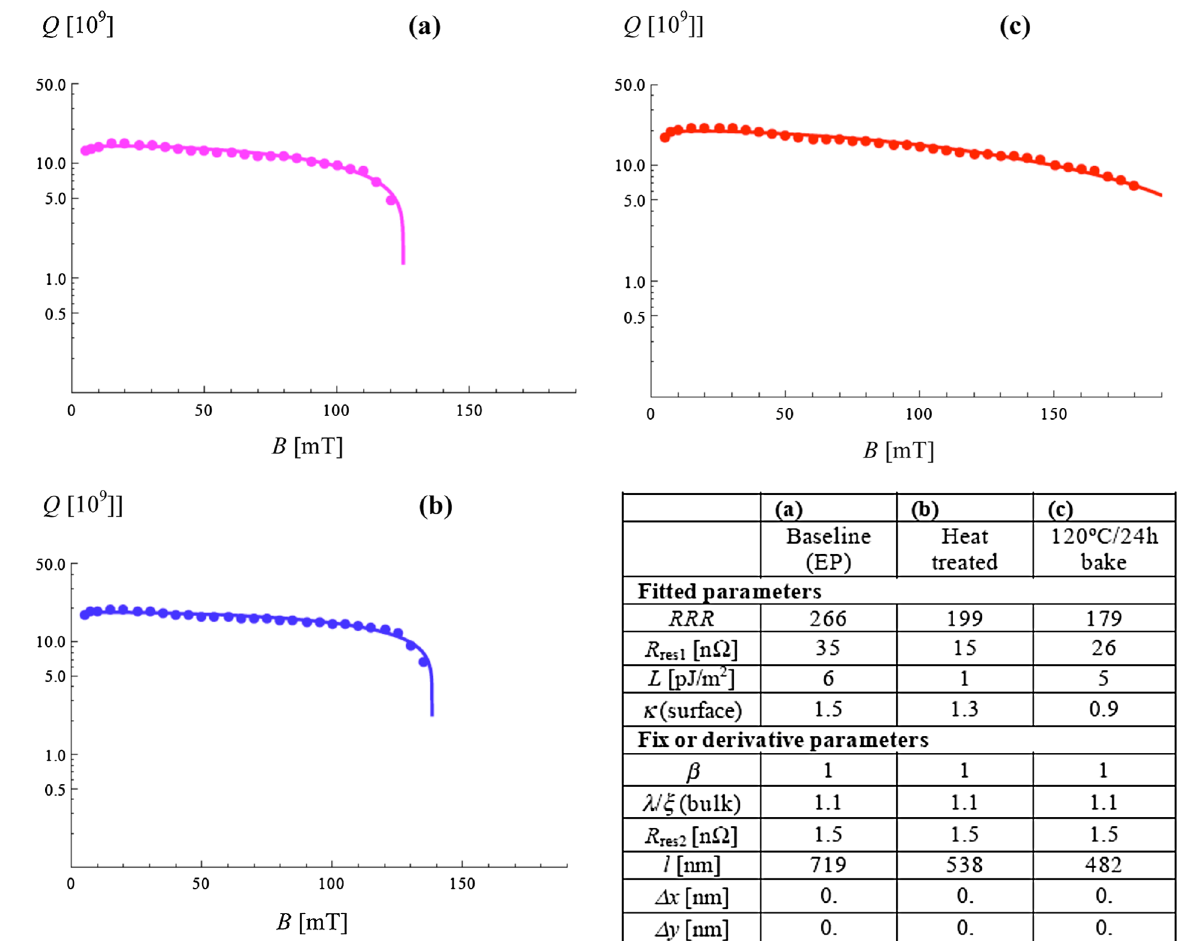
FIG. 7. Typical comparison of measured and fitted individual data: The Q ð B Þ curves were obtained for a 1300 MHz single cell cavity at 2.0 K made of fine grain niobium. (cid:2) x was intentionally set to 0 to avoid numerical instabilities during the fitting of data, because the (cid:3) function already forces the respective term to 0 for T < T (cid:5) . (cid:2) y was also intentionally set to 0 because it was small compared to the other numbers and otherwise oscillated between negative and positive values during the fitting of data.